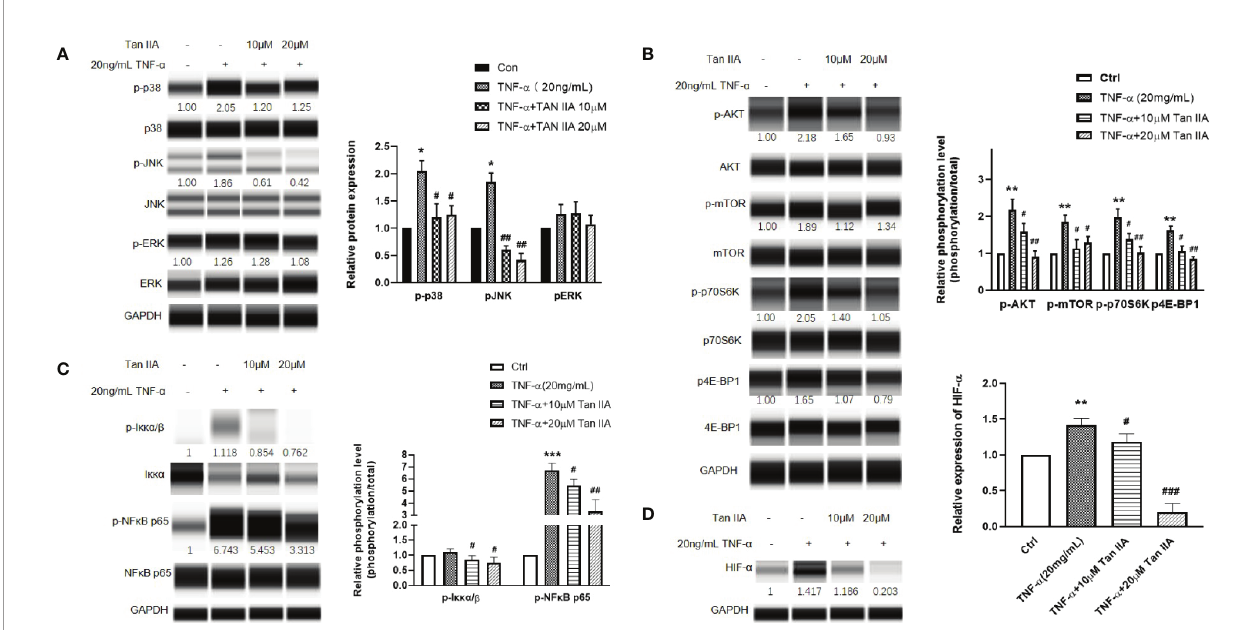
FIGURE 6 | The effect of Tan IIA on the intracellular phosphorylated activation of the MAPK and Akt/mTOR pathway induced by TNF- a in RA-FLSs. RA-FLSs were treated with TNF- a (20ng/mL) or/and Tan IIA (10 and 20 m M) for 24 h. (A) Western blot analysis was conducted to assess the expression and phosphorylation levels of p38MAPK, JNK, ERK, and FAK. Representative images of immune blot (left panel) and densitometric quanti fi cation phosphorylation/total of p38MAPK, JNK, and ERK expression (right panel). (B) Western blot analysis was conducted to assess the expression and phosphorylation levels of AKT, mTOR, p70S6K, and 4E-BP1. Representative images of immune blot (left panel) and densitometric quanti fi cation phosphorylation/total of AKT, mTOR, p70S6K, and 4E-BP1 expression (right panel). (C) Western blot analysis was conducted to assess the expression and phosphorylation levels of I kka and NF k B p65. Representative images of immune blot (left panel) and densitometric quanti fi cation phosphorylation/total of I kka and NF k B p65 expression (right panel). (D) Western blot analysis was conducted to assess the expression level of HIF- a . Representative images of immune blot (left panel) and densitometric quanti fi cation of HIF- a expression (right panel). Densitometry analysis from three independent experiments was used to quantitate the protein expression. * P < 0.05, ** P < 0.01, *** P < 0.001 vs. Ctrl (0 m M Tan IIA), # P < 0.05, ## P < 0.01, ### P < 0.001 vs. group treated by TNF- a (20